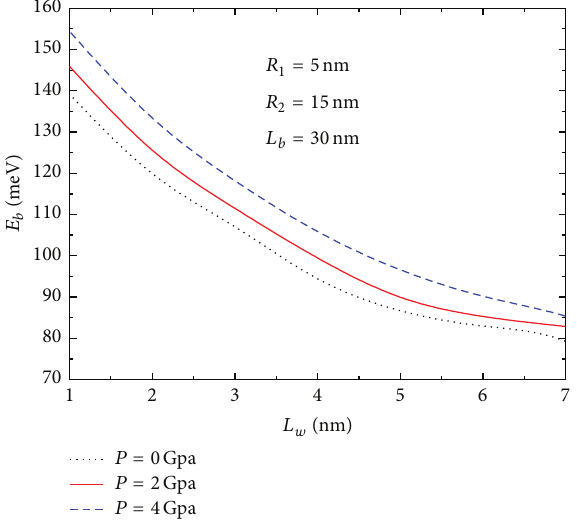
Figure 6: The ground-state donor binding energy in cylindrical wurtziteGaN/Al 𝑥 Ga 1−𝑥 NstrainedQRasafunctionoftheQRheight 𝑅 = 5 nm, 𝑅 = 15 nm, 𝐿 = 20 nm, and several values of 𝐿 𝑤 for 1 2 𝑏 the hydrostatic pressure (𝑃) .